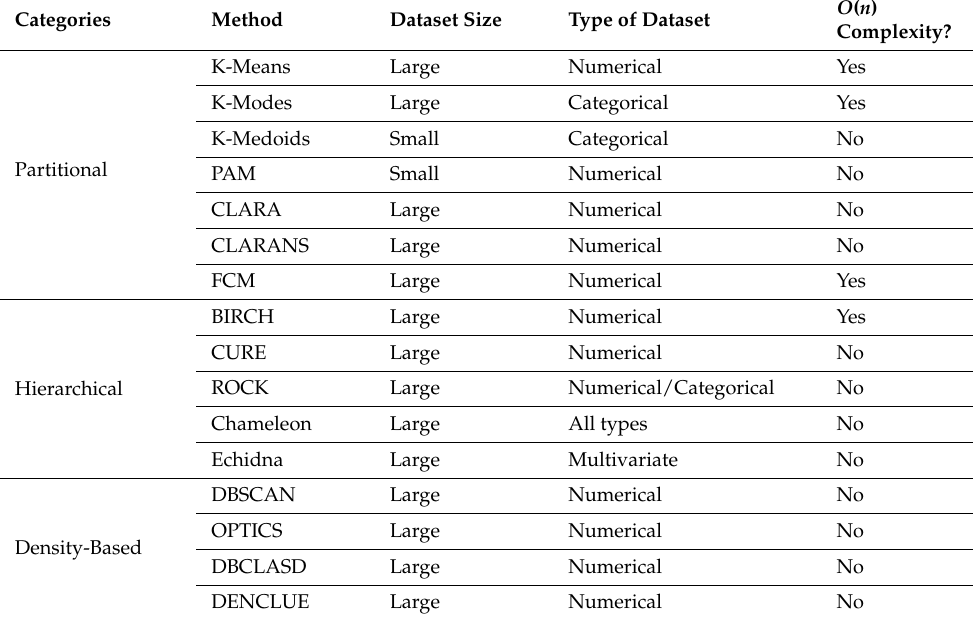
Table 1. Summary of Clustering